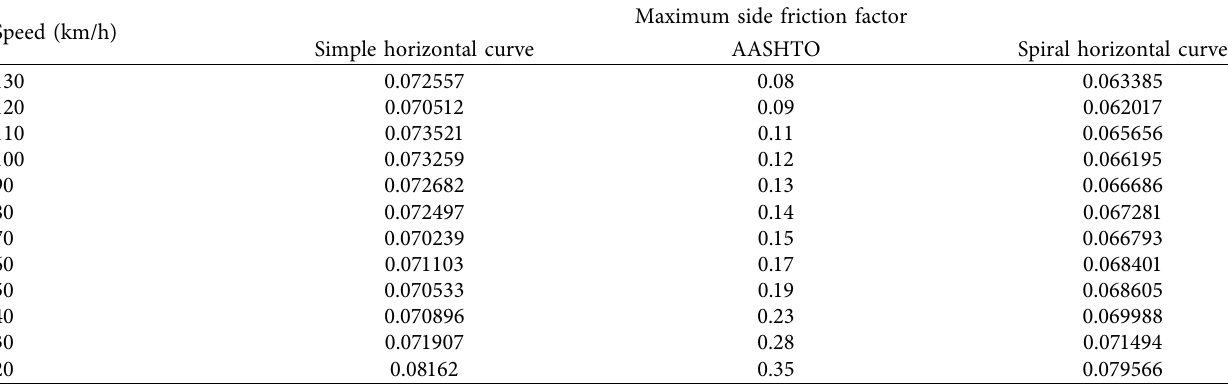
Table 14: Comparison of the maximum side friction factor between simple and spiral horizontal curves and AASHTO recommended values for sedan at a radius of 1R.